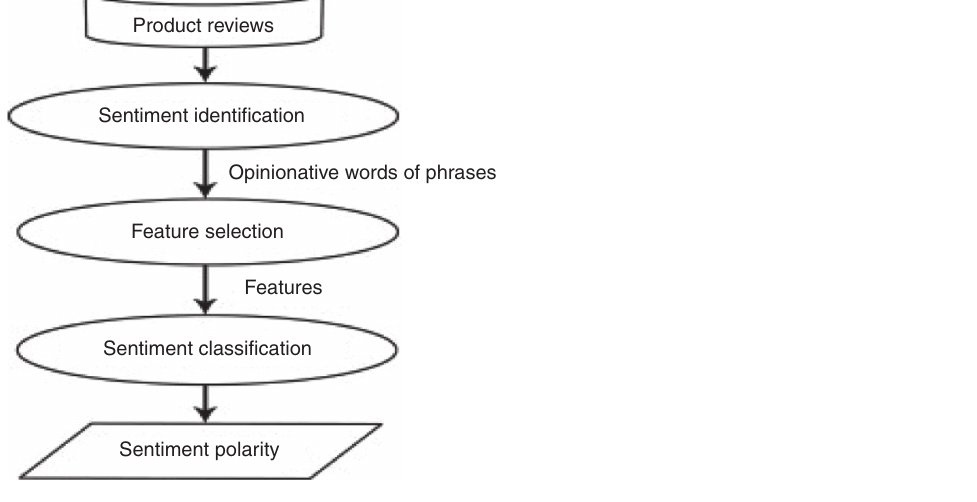
Figure 1: Sentiment Analysis Process